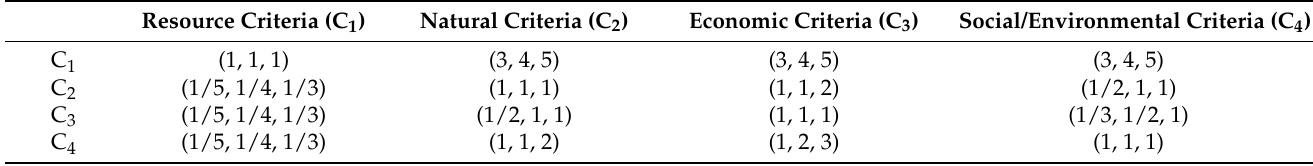
Table A5. Fuzzy pairwise comparison matrix of expert 5 (Weight: 0.1).